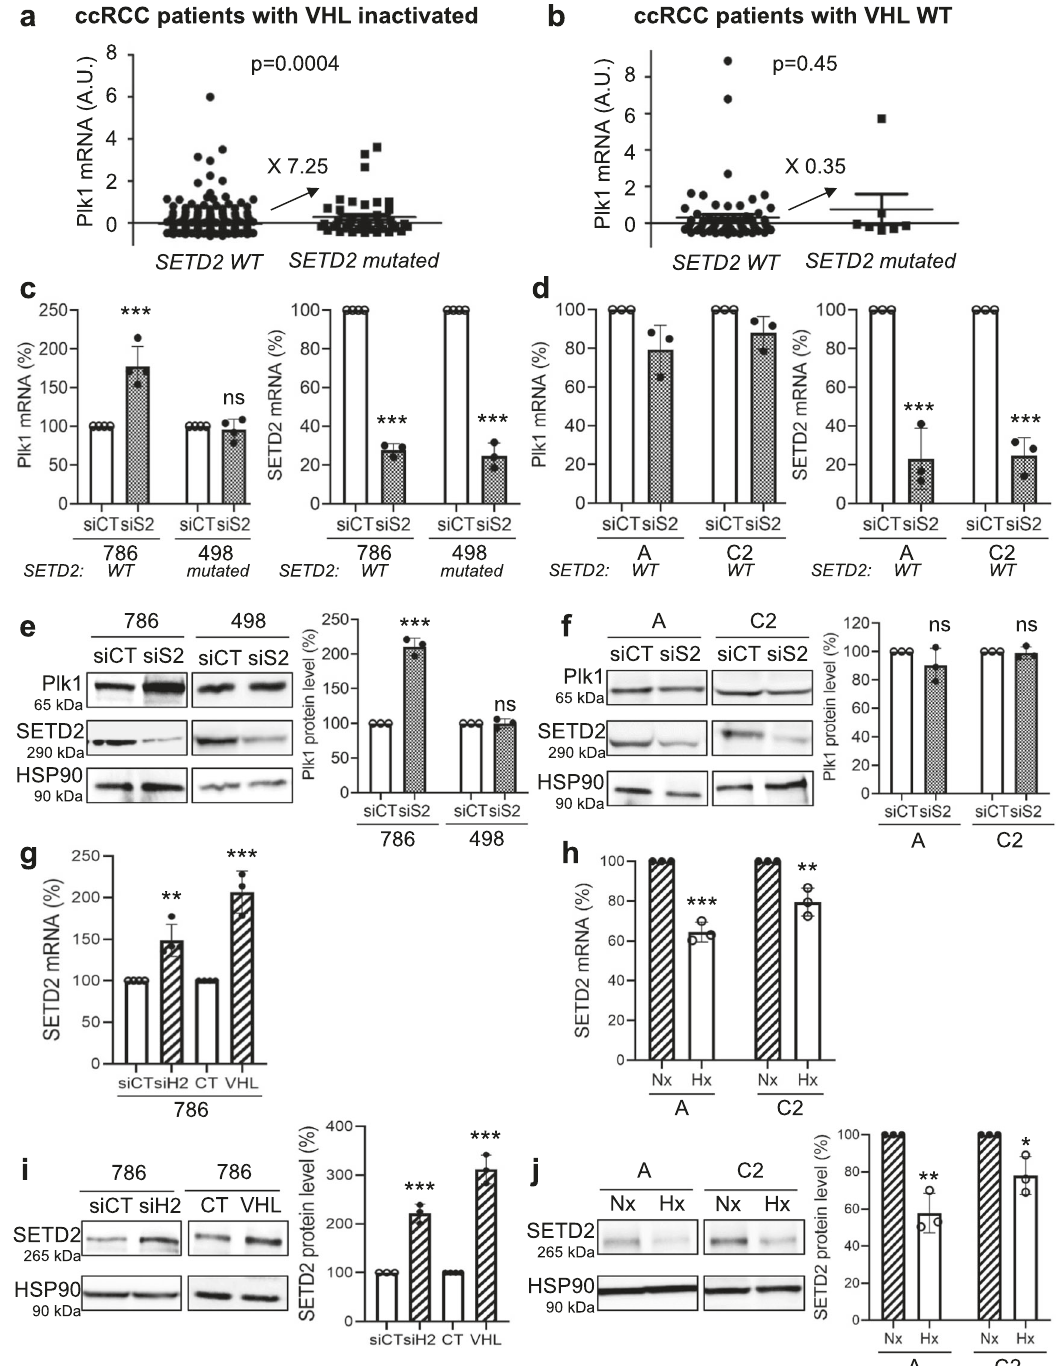
Fig. 3 SETD2 inactivation induced Plk1 expression in ccRCC VHL-i cells. a, b Levels of Plk1 mRNA ( z -score) in ccRCC patients with wild-type (WT) SETD2 were compared to the levels in ccRCC patients with mutated SETD2, in RCC patients with VHL-i ( a ), or in ccRCC patients with VHL-WT ( b ). c – f 786, A, and C2 have WT SETD2 gene while 498 have a mutated/inactivated SETD2 gene (TCGA and CCLE data). VHL-i 786 and 498 RCC cells ( c , e ), or VHL-WT RCC cells A and C2 ( d , f ) were transfected with siRNA against SETD2 (siS2) for 72 h. The Plk1 and SETD2 mRNA levels were determined by qPCR ( c , d ). Plk1 and SETD2 expression was evaluated by immunoblotting. HSP90 served as a loading control ( e , f ). g , h 786 cells (VHL-i) were transfected with siH2 for 48 h or an expression vector coding for VHL (stable expression, 786 + VHL). SETD2 mRNA levels were determined by qPCR ( g ). SETD2 expression was evaluated by immunoblotting. HSP90 served as a loading control. The quanti fi cation of Plk1 expression (mean of three experiments) is shown ( h ). i , j VHL-WT A and C2 cells were cultured in normoxia (Nx) or hypoxia 1% O 2 (Hx) for 24 h. SETD2 mRNA levels were determined by qPCR ( i ). SETD2 expression was evaluated by immunoblotting. HSP90 served as a loading control. The quanti fi cation of Plk1 expression (mean of three experiments) is shown ( j ). The value of the control condition was considered as the reference value (100). Results are the means of three or more independent experiments (biological replication) represented as mean ± SEM. Statistics were analyzed using an unpaired Student ’ s t test: * p < 0.05, ** p < 0.01, *** p <